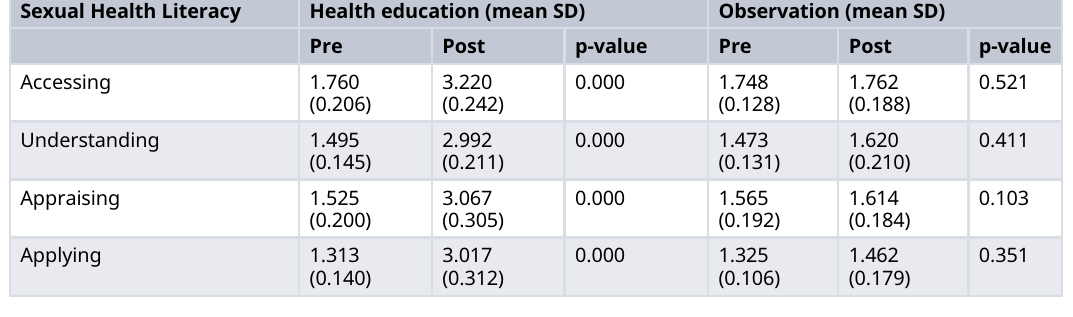
Table 3. Comparision of sexual health literacy scores among secondary school female students of both group (Pre vs Post of the health education). Sexual Health Literacy